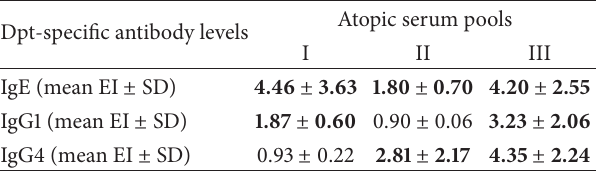
Table 3: Dermatophagoides pteronyssinus -specific IgE, IgG1, and IgG4 reactivity profile in three serum pools (I, II, and III) of atopic